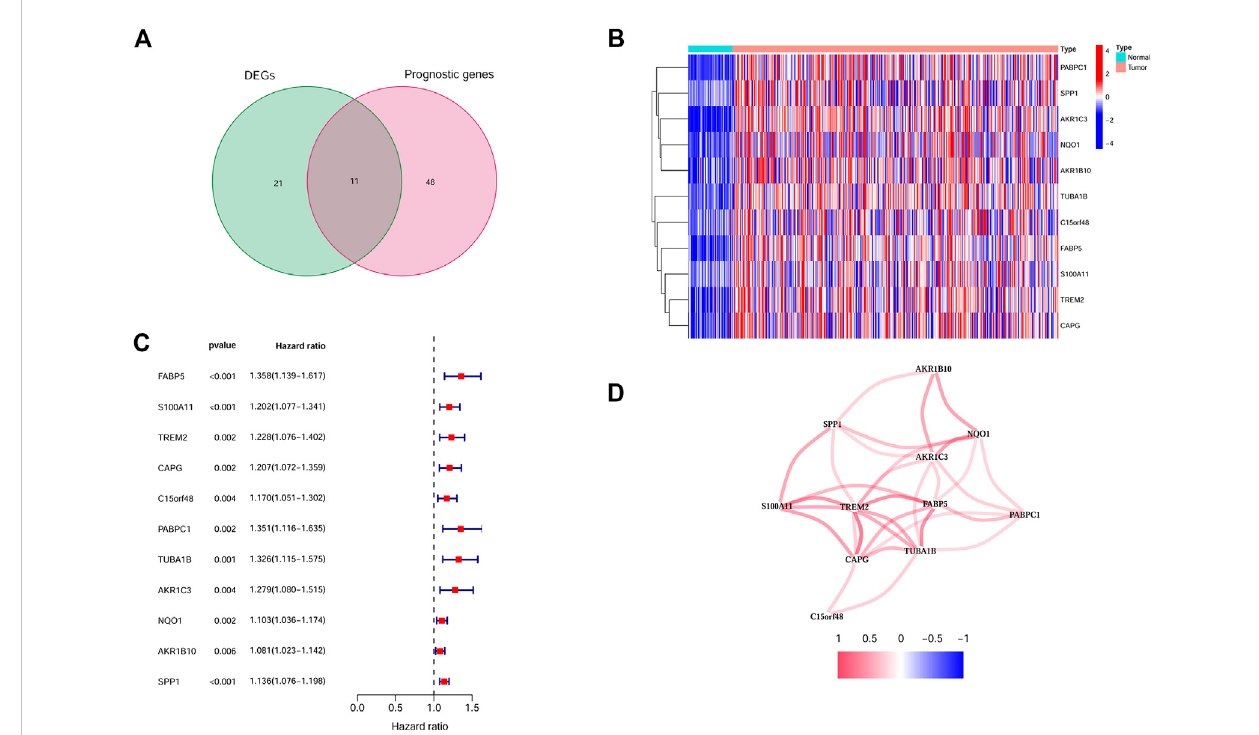
FIGURE 2 Identi fi cation of the candidate Myeloid cell marker genes. (A) Venn plot showing the intersection genes. (B) Heatmap showing the expressionof the 11 intersection genes. (C) Forest plots showing the prognostic value of the 11 intersection genes. (D) The correlations between 11 selected genes.